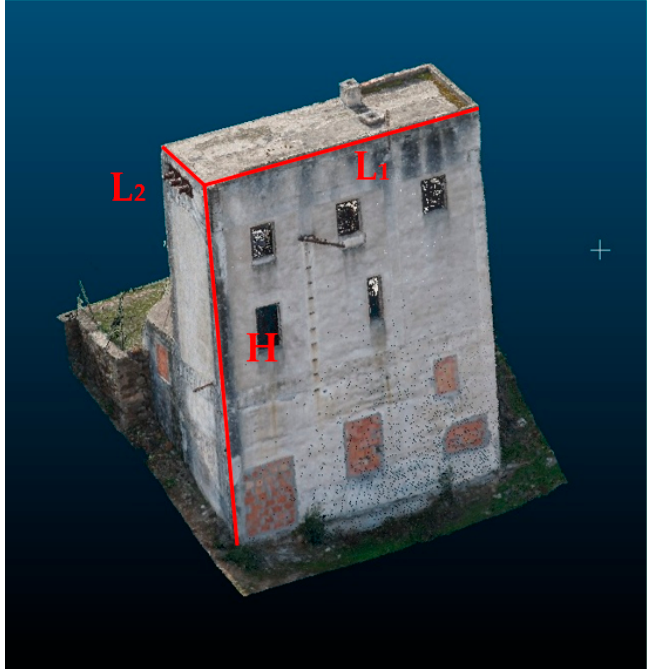
Figure 19. The measurements taken on the building.